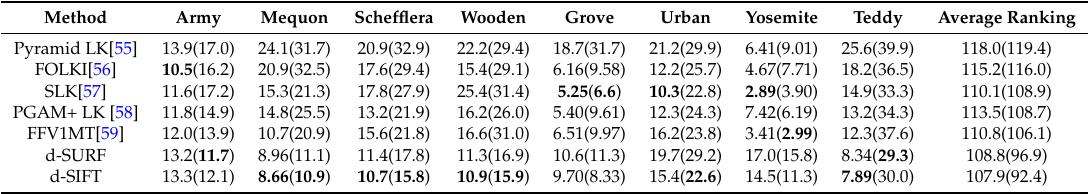
Table 5. Average (standard deviation) of angular error comparisons for the Middlebury test dataset. Method